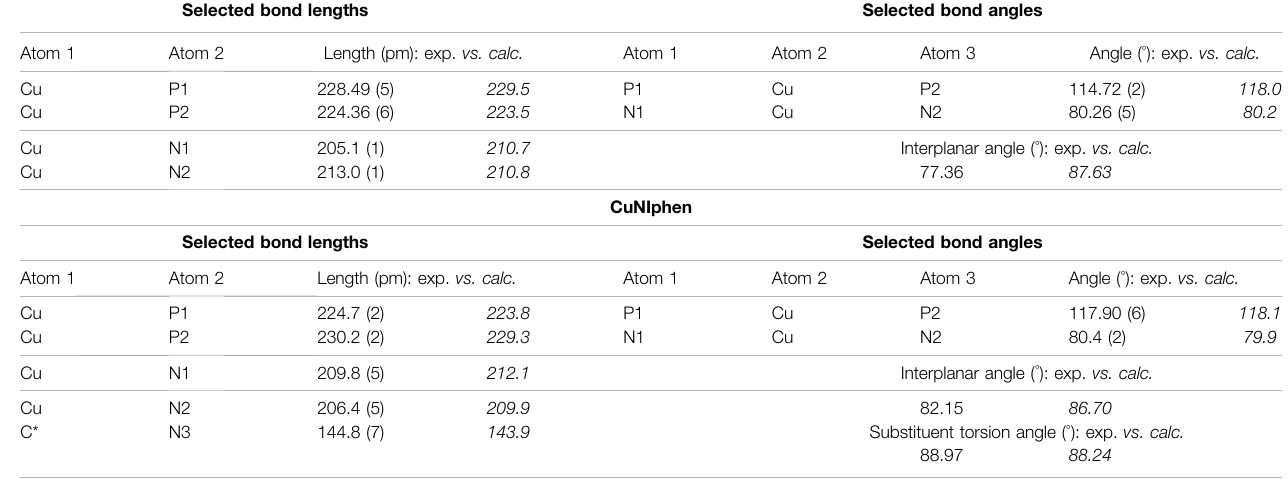
TABLE1| Selectedbondlengths,bondanglesandinterplanarangles(N-Cu-N vs .P-Cu-P)of Cuphen (top)and CuNIphen (bottom)includingthesubstituenttorsionangle (phen vs . naphthalimide). The interplanar angle corresponds to the angle between the two N-Cu-N and P-Cu-P planes, respectively. The bond length C*-N3 describes C-N bond from the phenanthroline to the naphthalimide. The table also compares the experimentally determined parameters (exp.) with those calculated by DFT (denoted italicized as calc. ). Further information can be found in the Supplementary Material S3.3 ). Cuphen